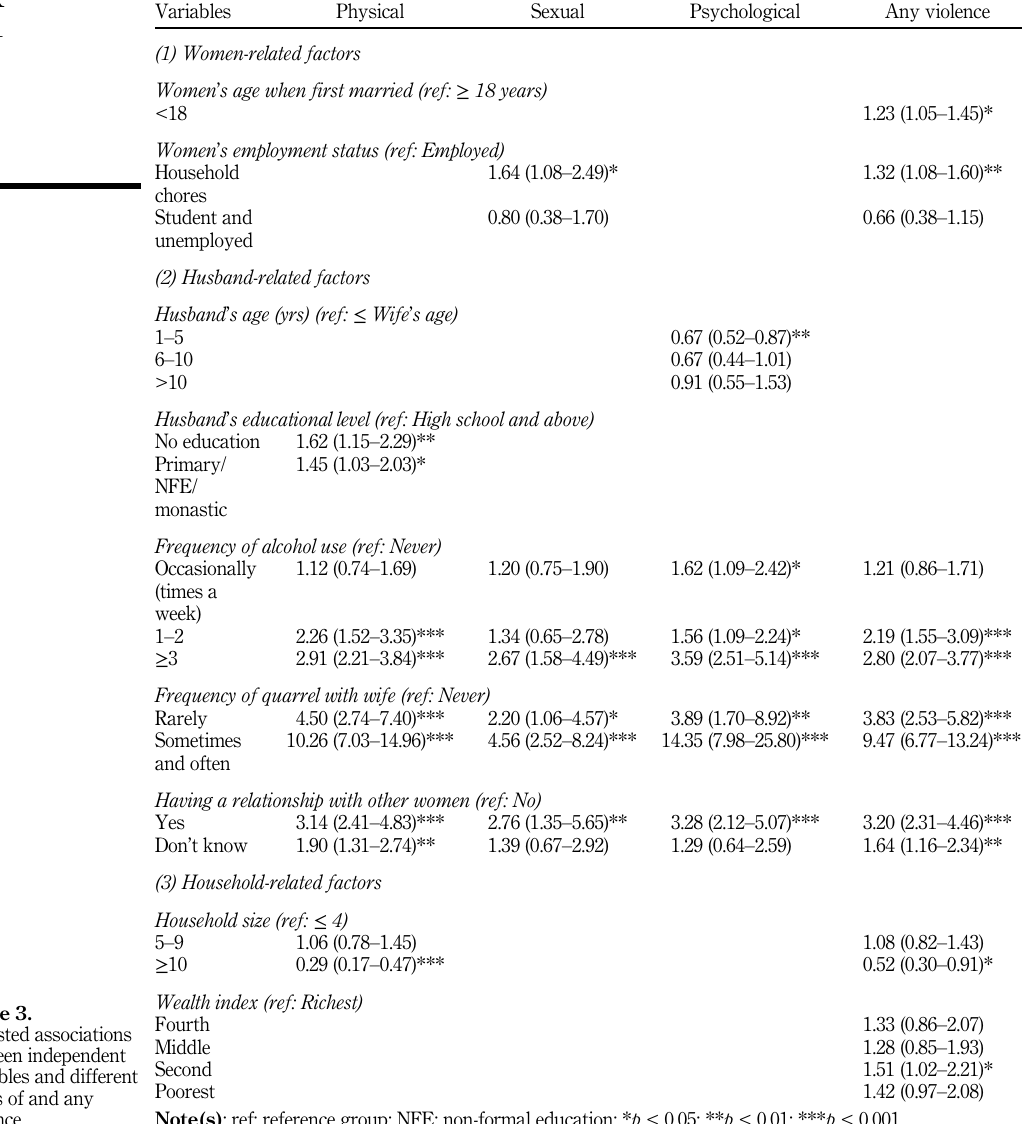
Table 3. Adjusted associations between independent variables and different forms of and any